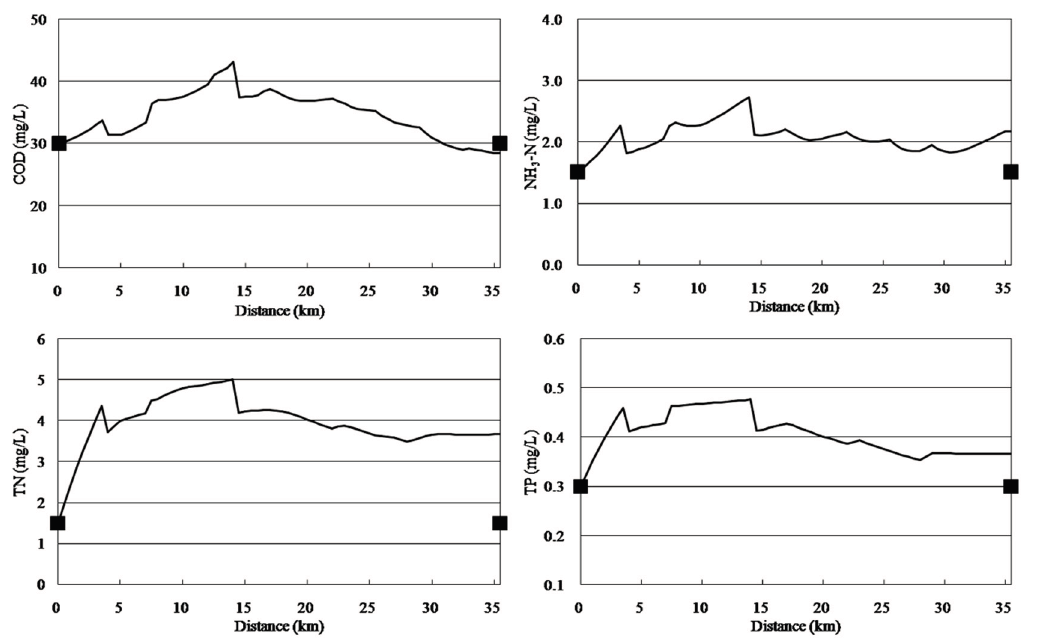
Figure 6. Simulation curves from implementing point source reduction of